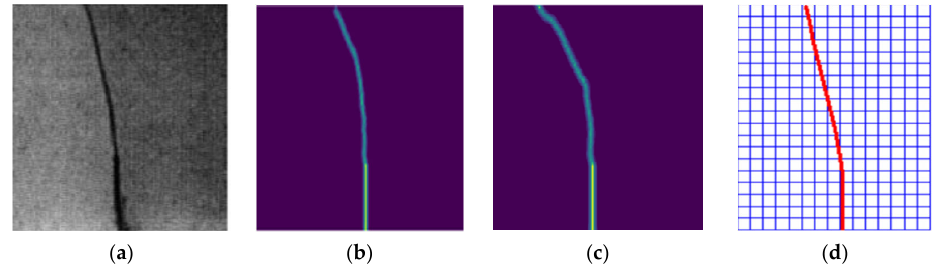
Figure 10. Crack path diagram: ( a ) Experimental result [17], ( b ) calculation results obtained from the improved PD model, ( c ) calculation results from the standard PD model and ( d ) extended finite element calculation results.